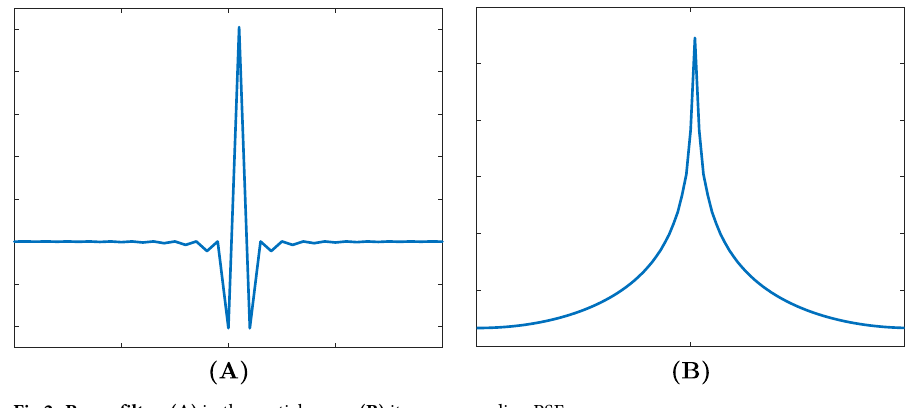
Fig 2. Ramp filter. (A) in the spatial space; (B) its corresponding